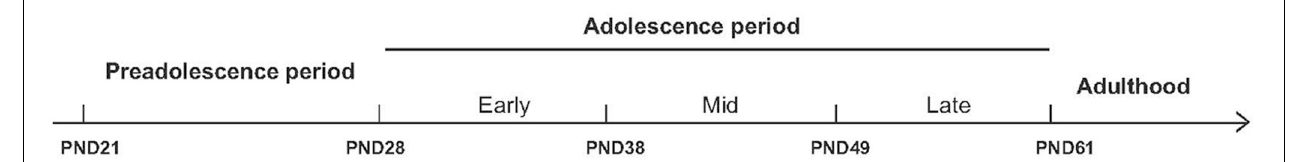
FIGURE 1 | Schematic overview of the various stages of adolescence in rats. To model the effects of cannabinoid exposure at different developmental stages, rats can be treated chronically throughout the entire adolescent period (from PND28 through PND61) or during specific stages of